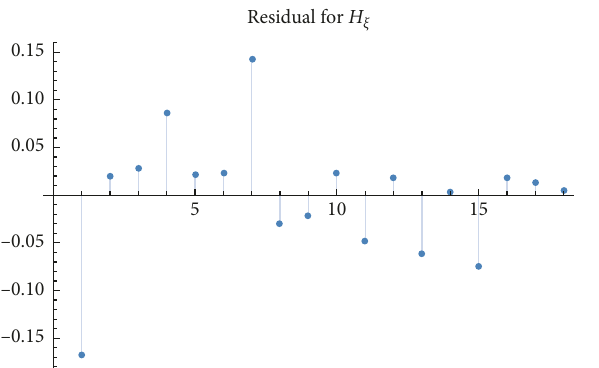
superimposed by the fitted 1